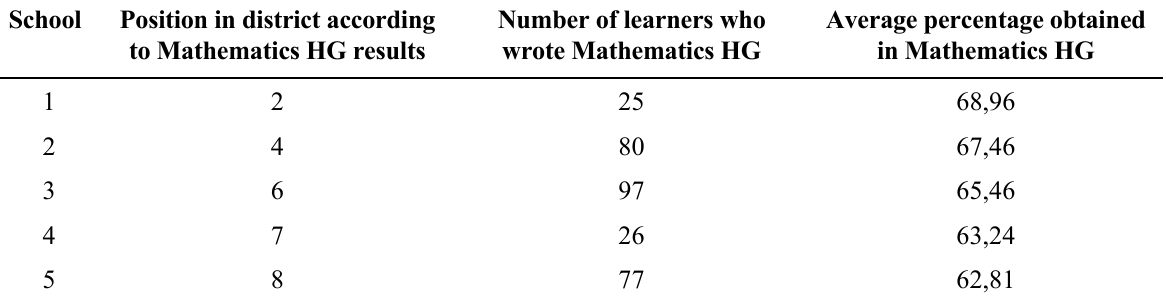
Table 2 : Achievement in the 2006 Senior Certificate Examination in Mathematics